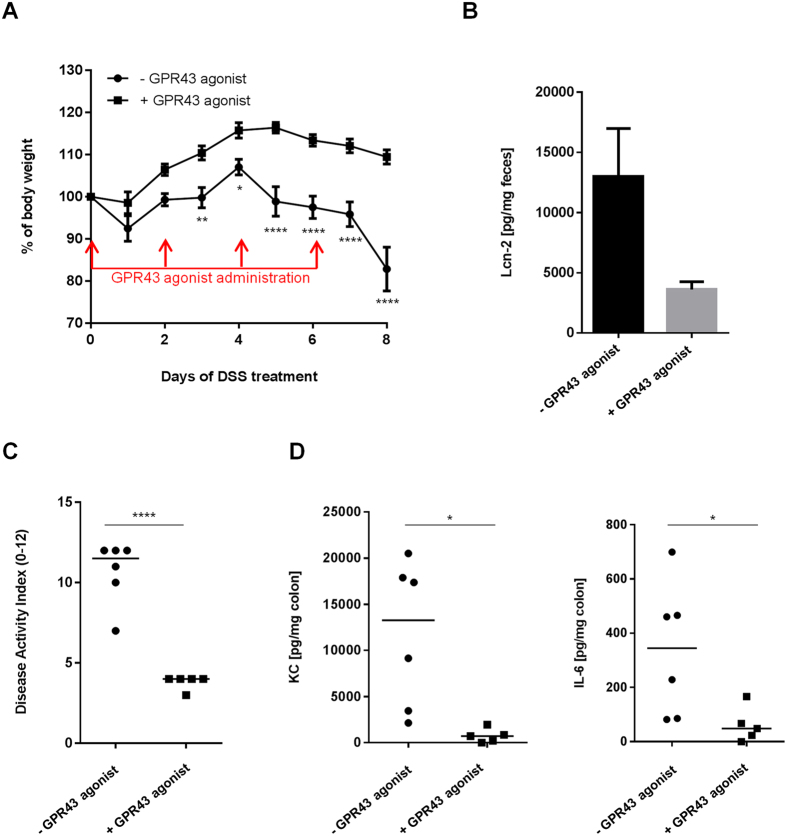
Pharmacological GPR43 activation prevents gut inflammation.(A) Evolution of body weight, (B) Fecal Lcn-2 levels, (C) DAI at day 8 after the beginning of the treatment and (D) IL-6 and KC cytokine release by colonic mucosa. *P < 0.05; **P < 0.01; ***P < 0.001, ****P < 0.0001.